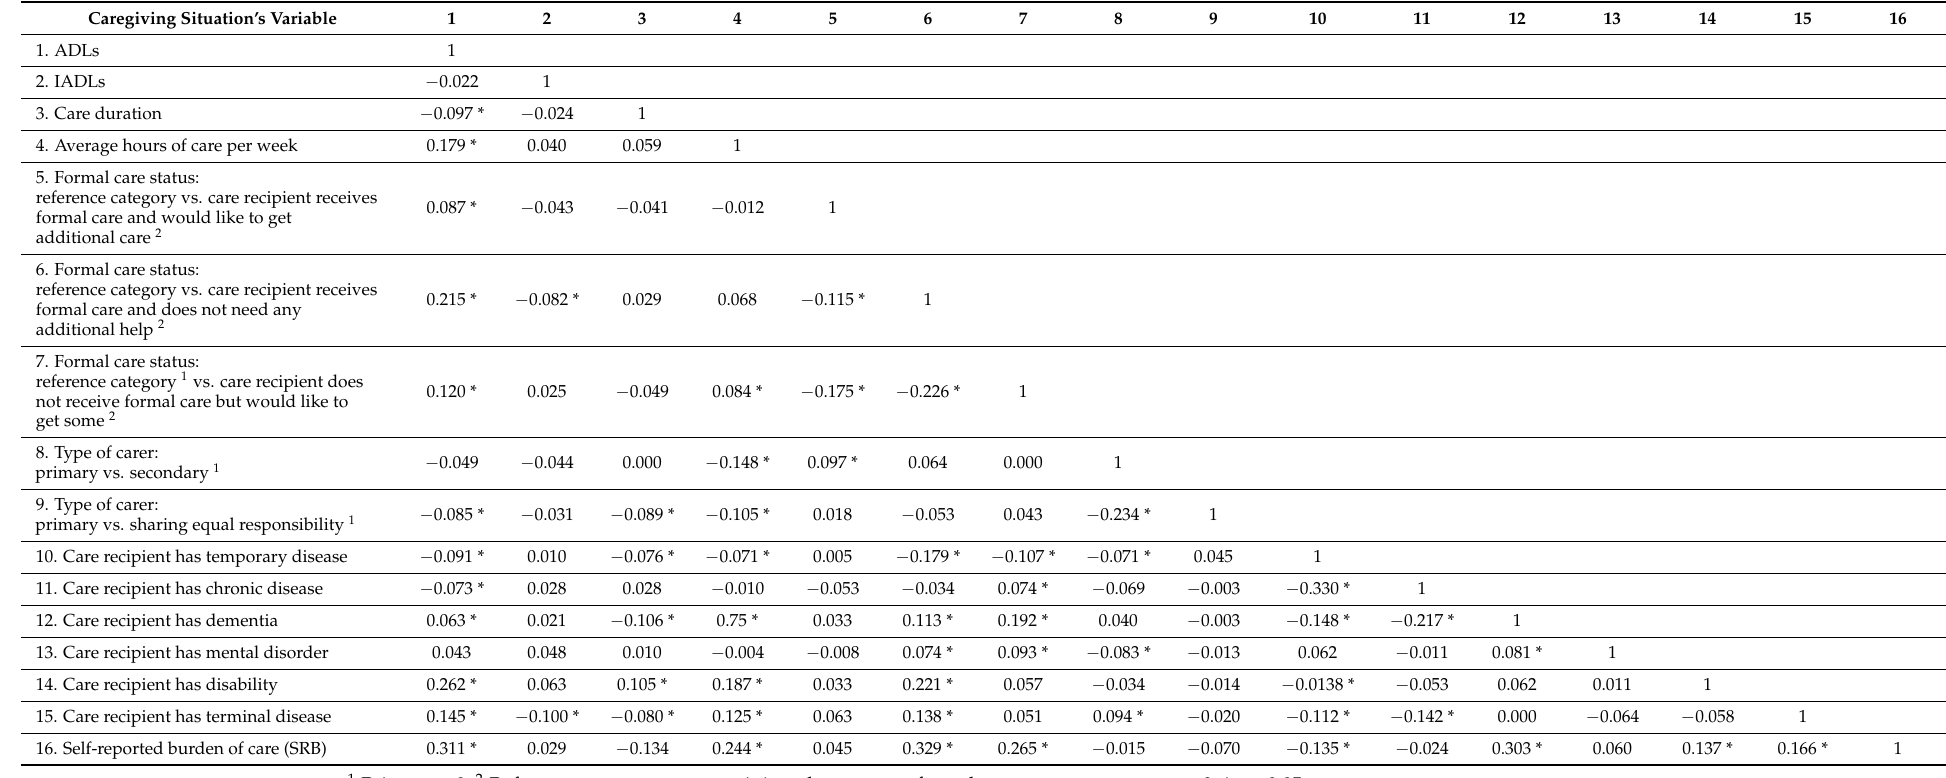
Table 3. Pearson correlations among caregiving situation characteristics’